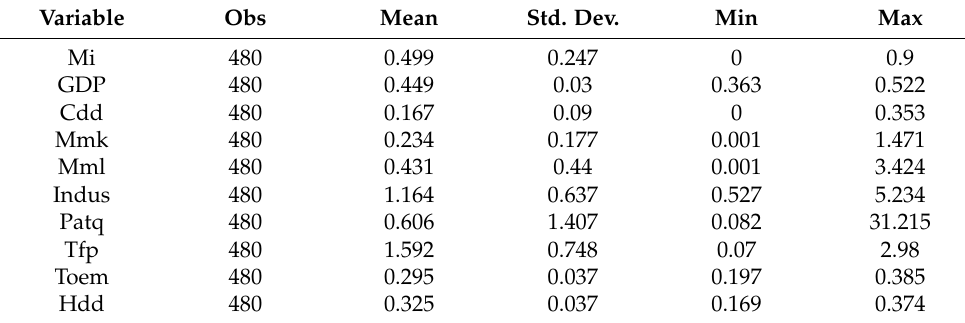
Table 1. Description of statistical